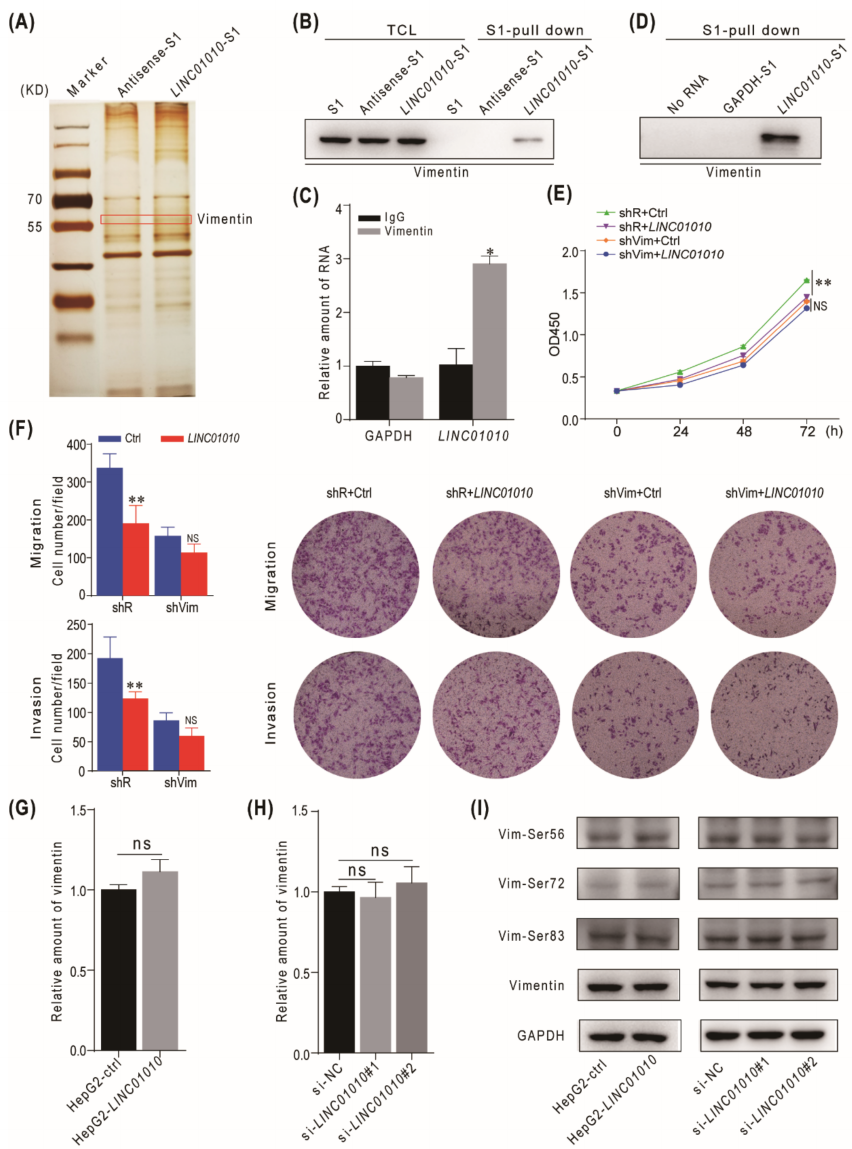
Figure 3. LINC01010 interacts with vimentin. ( A ) The plasmids expressing LINC01010 -S1 or Antisense-S1 were transfected into L02 cells. The cell lysates were harvested and subjected to the S1 pull-down assay. The pull-downed proteins were visualized using sliver staining. The band in red box was subjected to mass spectrometry. ( B ) L02 cells were transfected with LINC01010 -S1, Antisense-S1 expression plasmids or control plasmid. The cell lysates were collected and subjected to S1 pull-down assay. The bound proteins were immunoblotted with vimentin antibody. ( C ) L02 cells were transfected with pll3.7- LINC01010 -S1 or control plasmid for 48 h. The cell lysates were collected and subjected to immunoprecipitation with vimentin antibody or control IgG. The co-precipitated RNA was subjected to real-time PCR with GAPDH as a negative control. ( D ) S1 pull-down was performed by using the recombinant vimentin with a C-terminal His-tag and LINC01010 -S1 transcribed in vitro or GAPDH-S1 mRNA as the control, followed by immunoblotting with vimentin antibody. ( E ) HepG2 cells were infected with lentivirus carrying shVim or shR and then transfected with LINC01010 expression plasmid or control plasmid. Growth curves of indicated cells were measured by the CCK8 assay. ( F ) HepG2 cells were infected with lentivirus carrying shVim or shR and then were transfected with LINC01010 expression plasmid or control plasmid. The cells were then subjected to migration and invasion transwell assays. The representative of migration and invasion assays (right panels) and the corresponding statistical results (left panels) are shown. ( G , H ) The relative mRNA level of vimentin in LINC01010 overexpression ( G ) or knockdown ( H ) HepG2 cells was detected by real-time PCR, ns indicates a difference which is not significant. ( I ) These protein levels in LINC01010 -overexpressed or knockdown HepG2 cells were detected by immunoblotting with indicated antibodies. * p < 0.05, ** p < 0.01, means ± SD are shown, ns - no